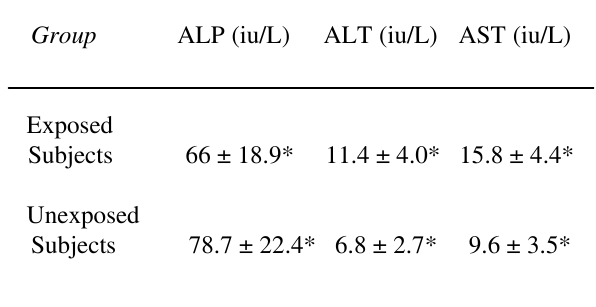
Table 2: Serum alkaline phosphatase (ALP), alanine aminotransferase (ALT) and as partate aminotransferase (AST) concentrations in human subjects exposed to lead and in unexposed